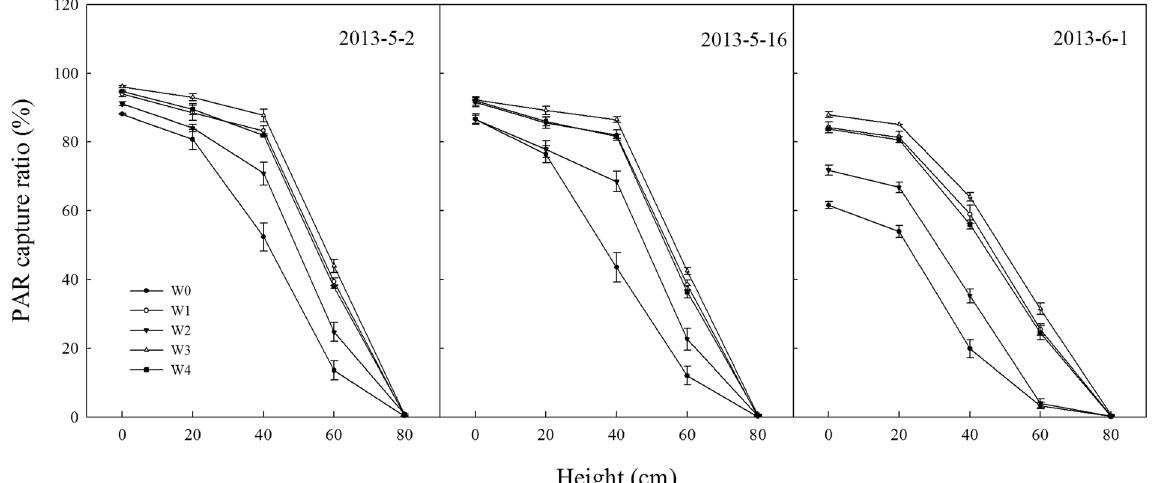
Figure 4. Changes of PAR capture ratio in different plant heights at May 2, May 16, and June 1 in 2013 of different treatments in 2012/2013 growing season: rainfed (W0), a local supplemental irrigation practice with 60 mm of irrigation each at jointing and anthesis (W1), supplemental irrigation determined by measuring 0–20 cm (W2), 0–40 cm (W3), and 0–60 cm (W4) soil layers moisture and brought the soil moisture to 65% field capacity (FC) at jointing and 70% FC at anthesis. The vertical bars represent standard error of the mean (n =